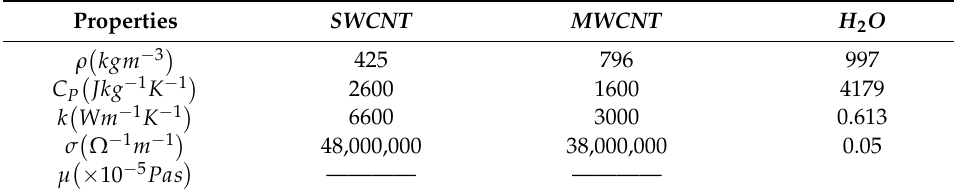
Table 2. Properties of each phase. Anuar